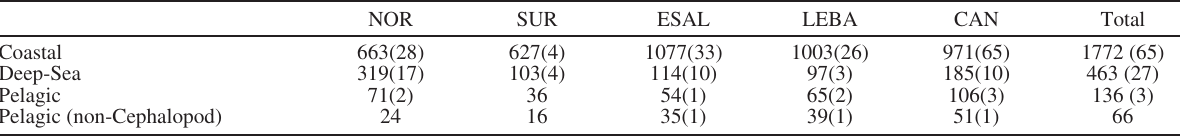
Table 4. – Number of molluscan species recorded in Spanish jurisdictional waters, per demarcation and biome. First number, “P” records, number in brackets, “R” records. NOR SUR ESAL LEBA CAN Coastal